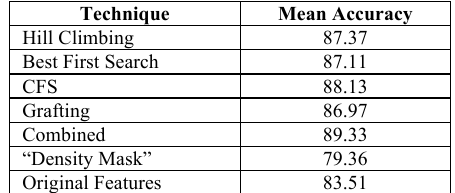
83.51 Table 4 : Evaluation of different techniques for emphysema classification given by mean